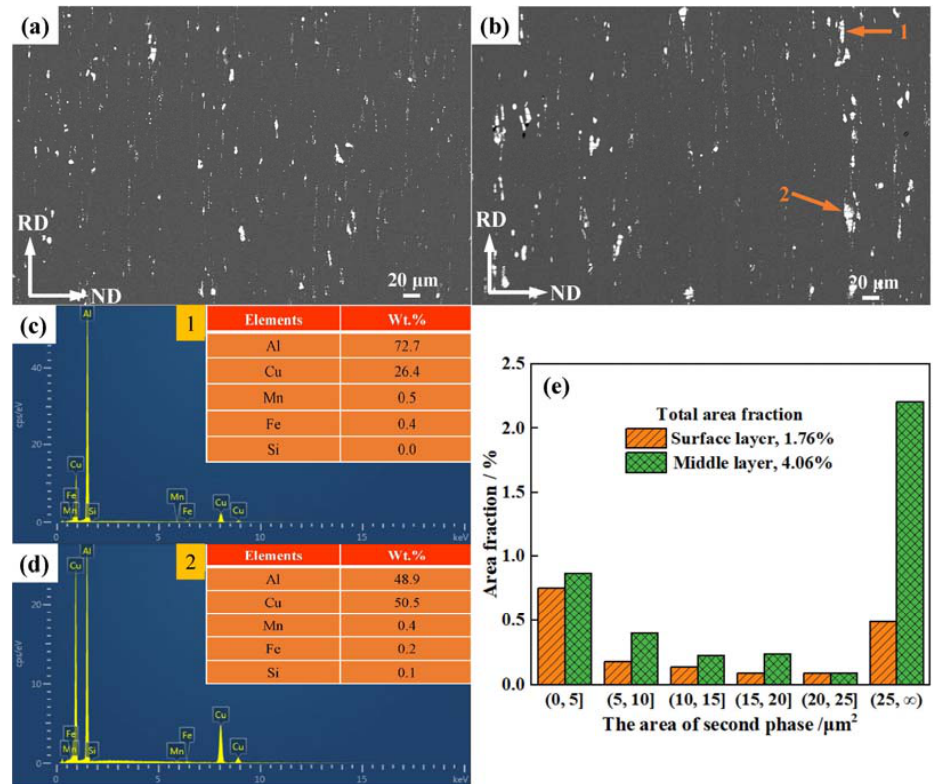
Figure 4. The second phase distribution of 2519A aluminum alloy in the thickness direction: ( a ) Surface layer; ( b ) Middle layer; ( c , d ) EDS results of the second phase in ( b ); ( e ) the area fraction of second phase in ( a , b ).